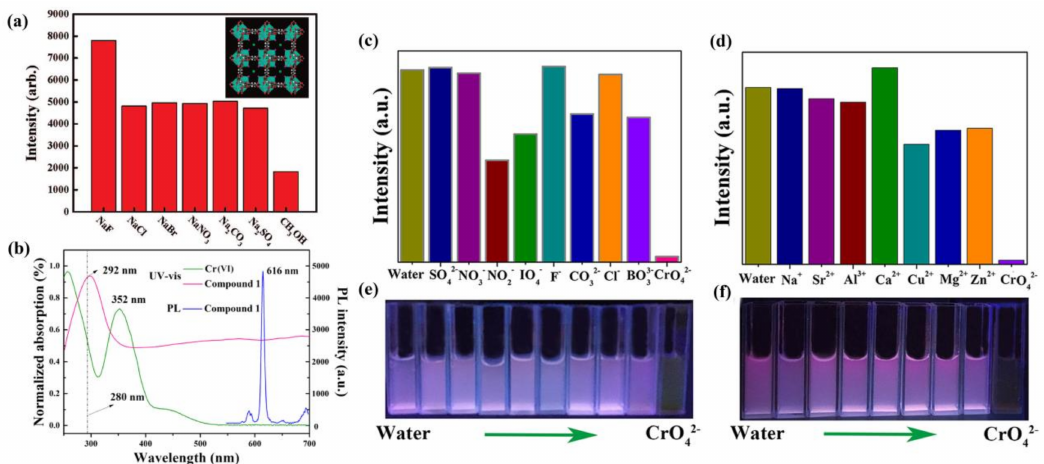
Figure 4. ( a ) 5 D 4 → 7 F 5 transition intensities of [Tb(BTC) · G] activated in different types of 10 − 2 M NaX and Na 2 X methanol solution (excited and monitored at 353 and 548 nm, respectively). The insert figure is the single crystal X-ray structure of [Tb(BTC) · G] activated in methanol containing NaF with the model of fluoride (green) at the center of the channel involving its hydrogen-bonding interaction with terminal methanol molecules (methanol oxygen, purple; the methyl group from methanol is omitted for clarity). Reprinted with permission from [78]. Copyright 2008, American Chemical Society. ( b ) Luminescence spectrum and UV − vis absorption spectra. ( c , d ) Luminescence intensity of 5 D 0 → 7 F 2 of Eu 3+ at 616 nm dispersed in different aqueous solutions of various anions and cations. ( e ) Luminescence in different anion solutions (excited at 365 nm), corresponding to figure ( c ). ( f ) Luminescence in different cation solutions (excited at 365 nm), corresponding to figure ( d ). Reprinted with permission from [81]. Copyright 2017, American Chemical